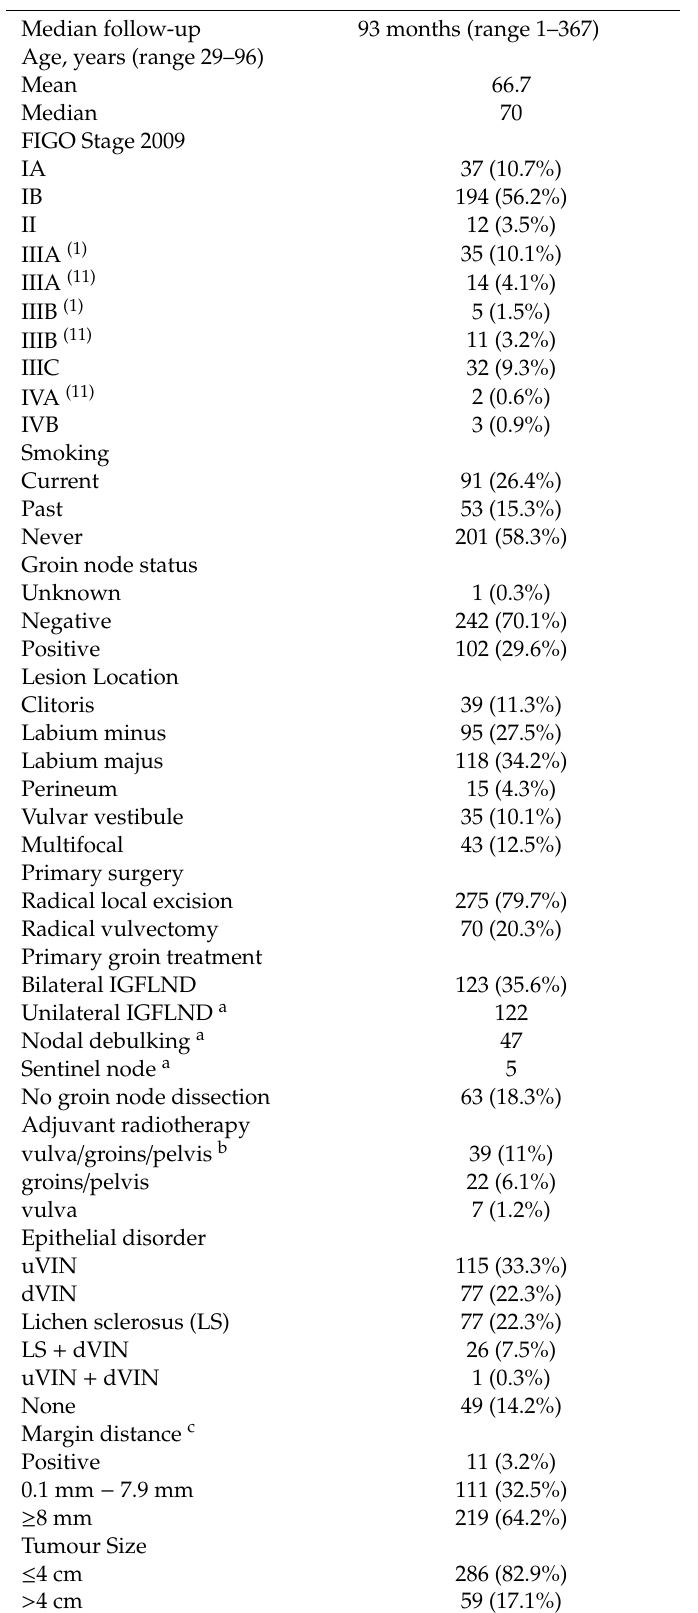
Table 1. Clinical, surgical, and pathological characteristics of the vulvar. Squamous cell carcinoma cohort ( n =